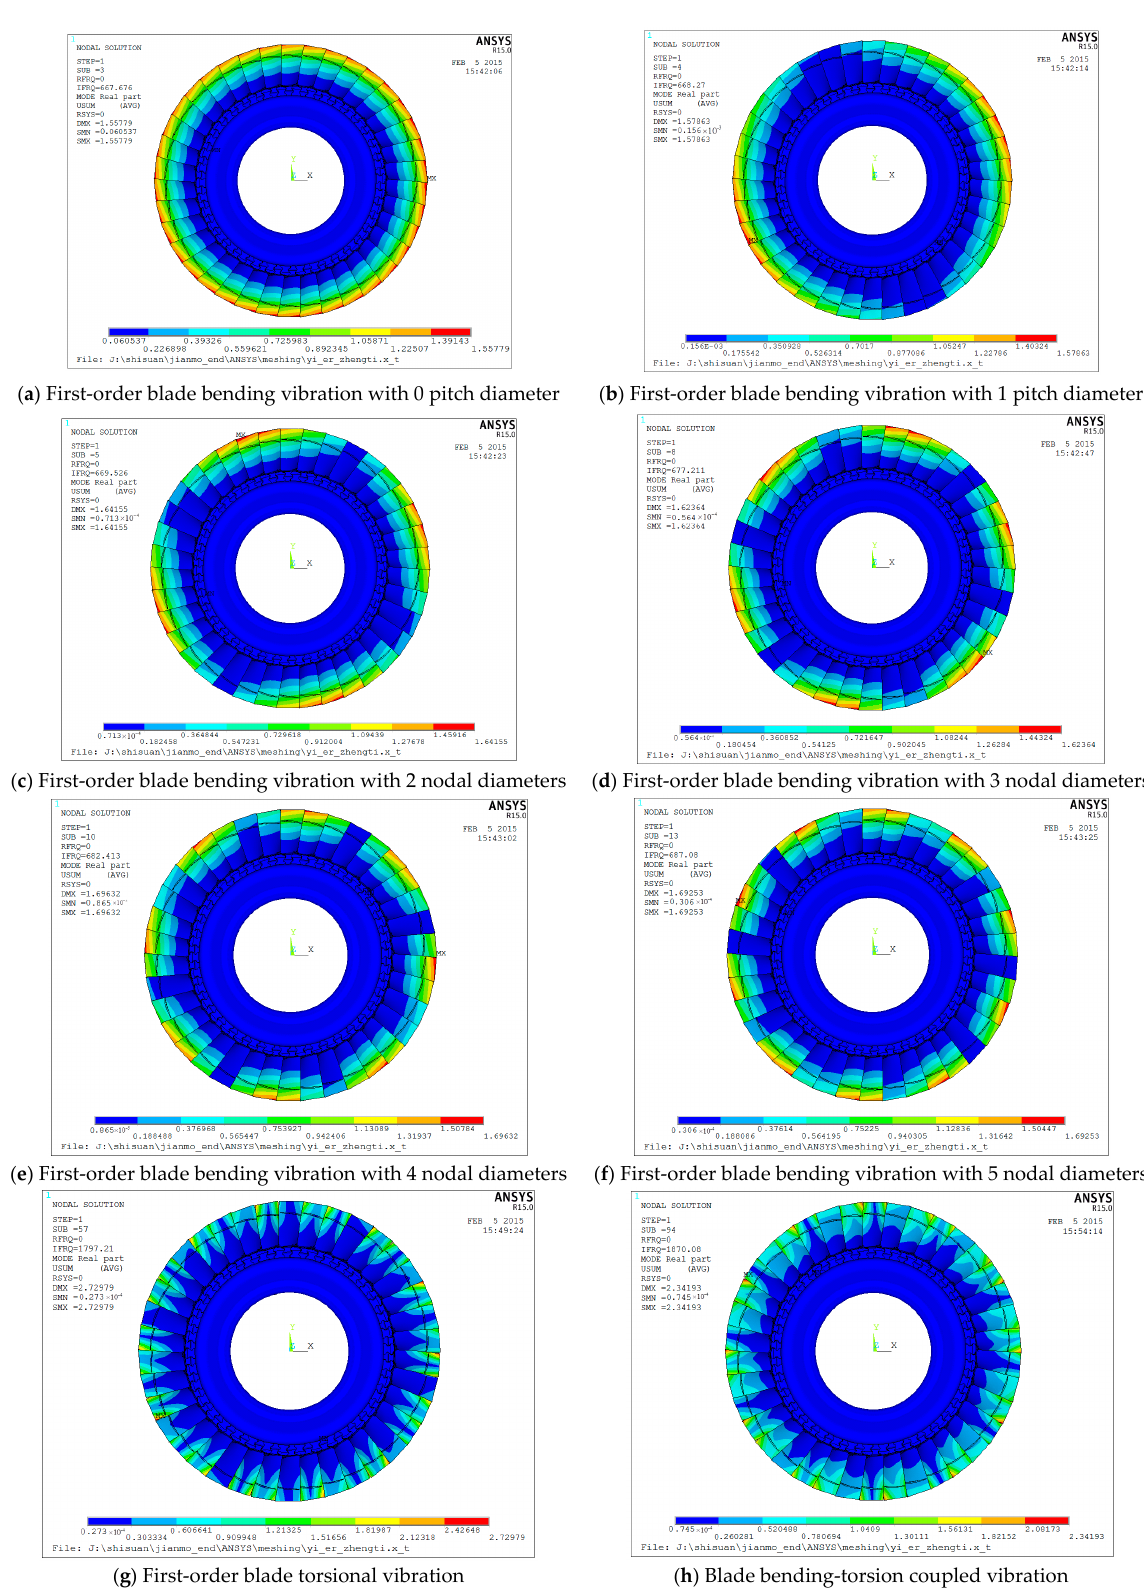
Figure 10. Mode pattern of a typical order of the first-stage bladed disk system. Through analysis, it can be seen that the low order mode shape of the first-stage bladed disk system is the first order bending vibration of the blade according to the